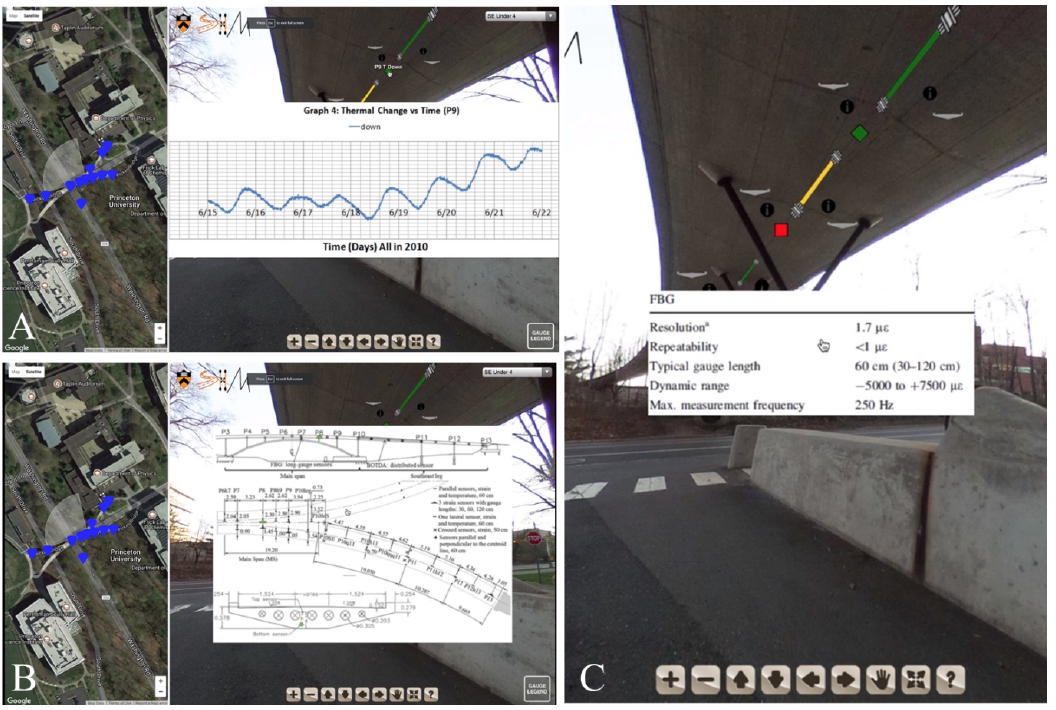
Figure 7. Examples of VT interactions showing ( A ) thermal change over time; ( B ) technical drawings, and ( C ) strain sensor